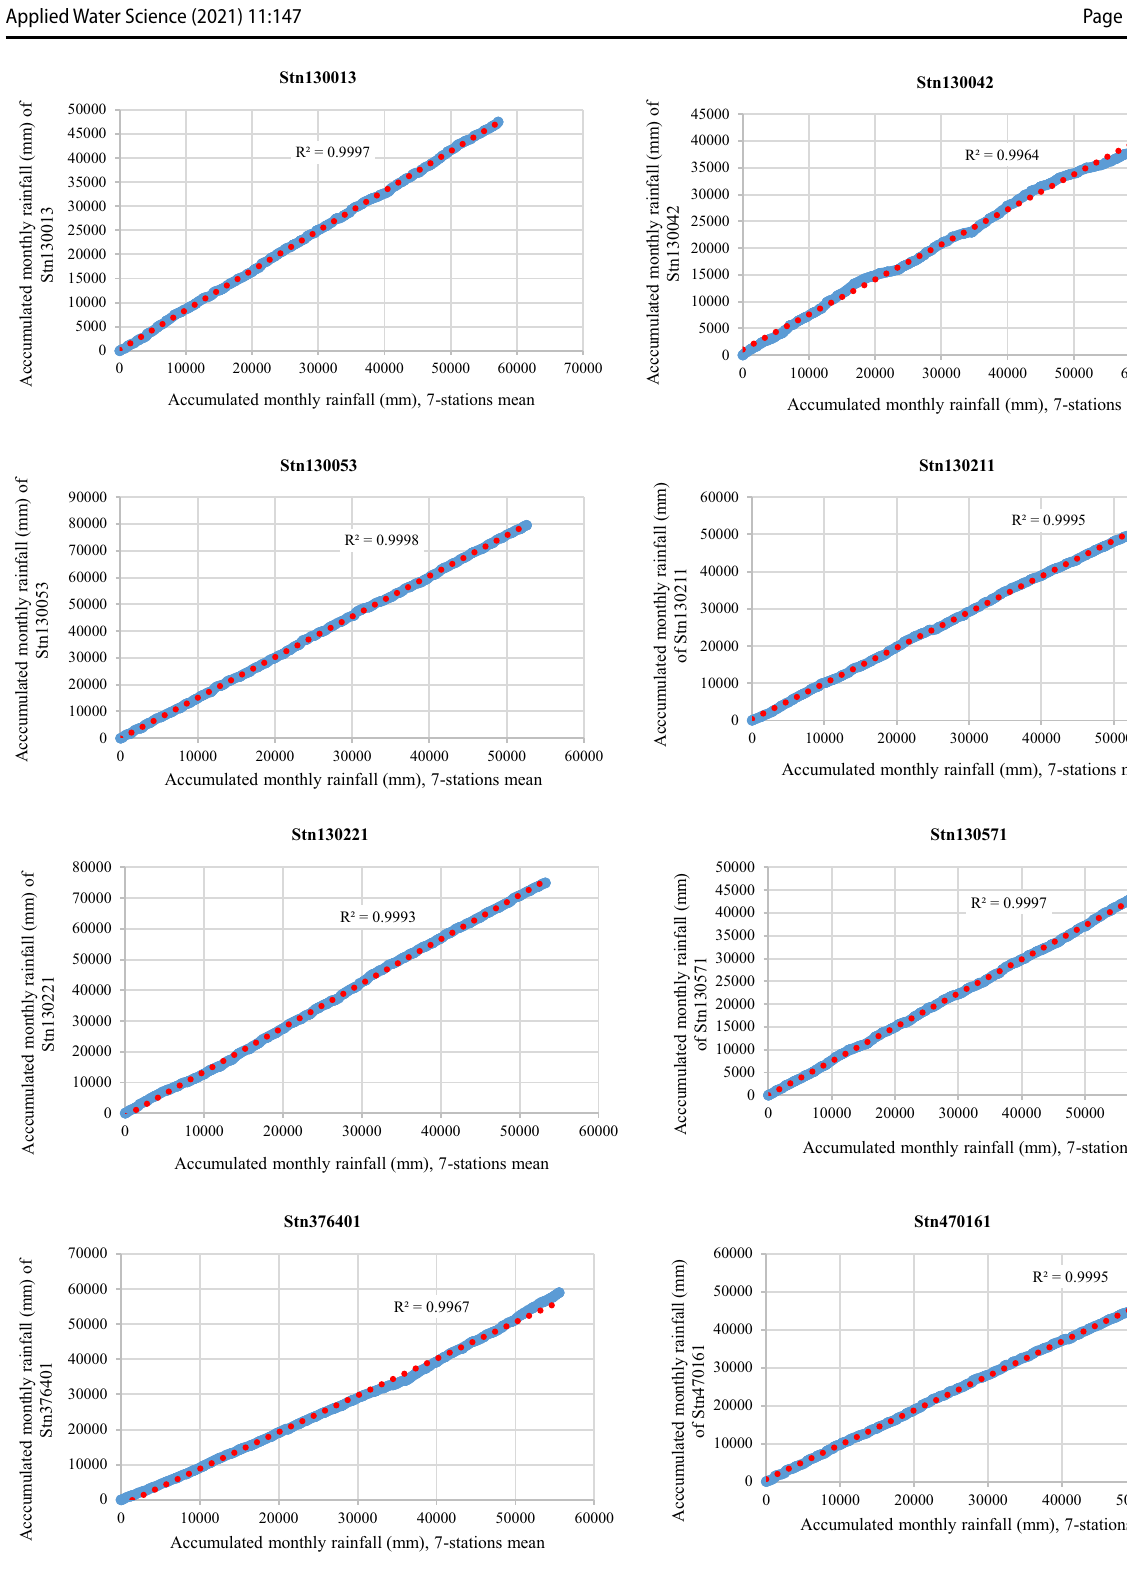
Fig. 3 Double mass curve plots of rainfall stations for the Mae Klong River